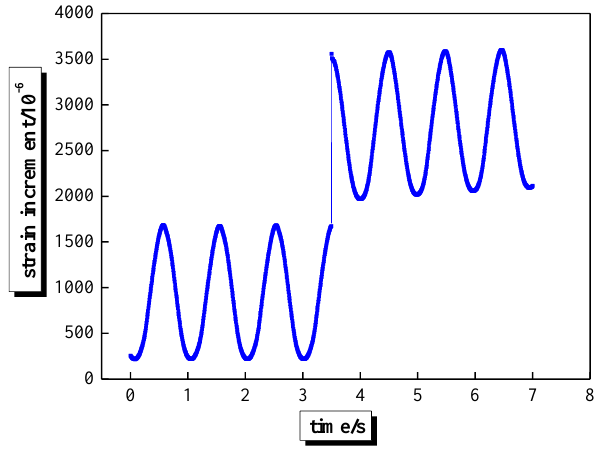
Figure 7. Strain increment-time curves of steel strand failure.